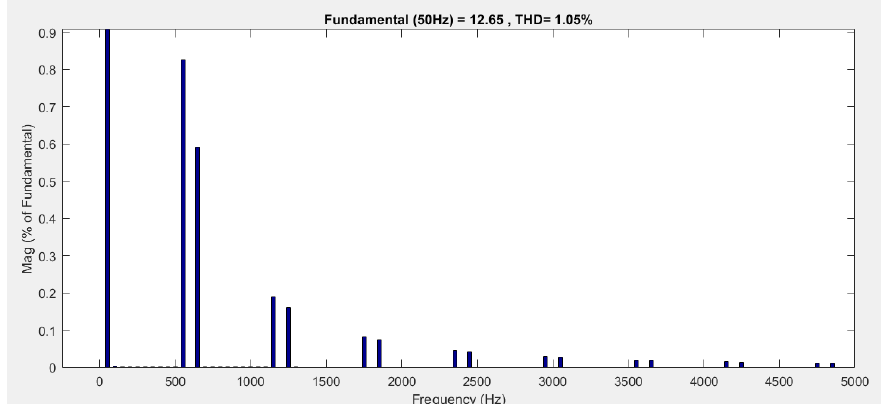
Figure 6. Spectral analysis of the grid current ( i L1 ) drawn by the rectifier with the current modulator (the current modulator is based on an ideal current source).